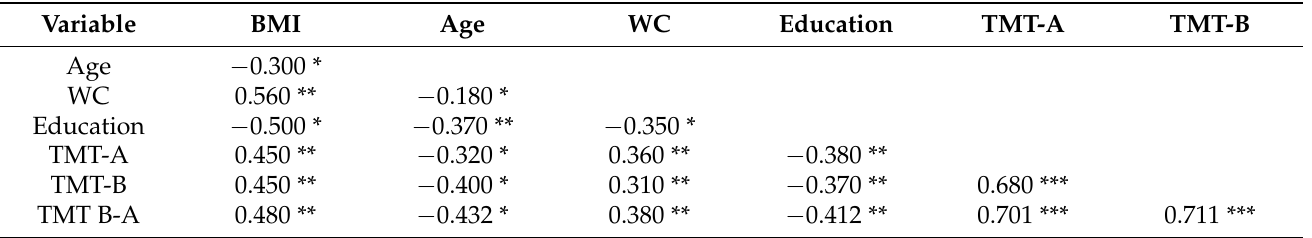
Table 2. Pearson correlations of scores on time to complete TMT-A and TMT-B with age, BMI, WC, and